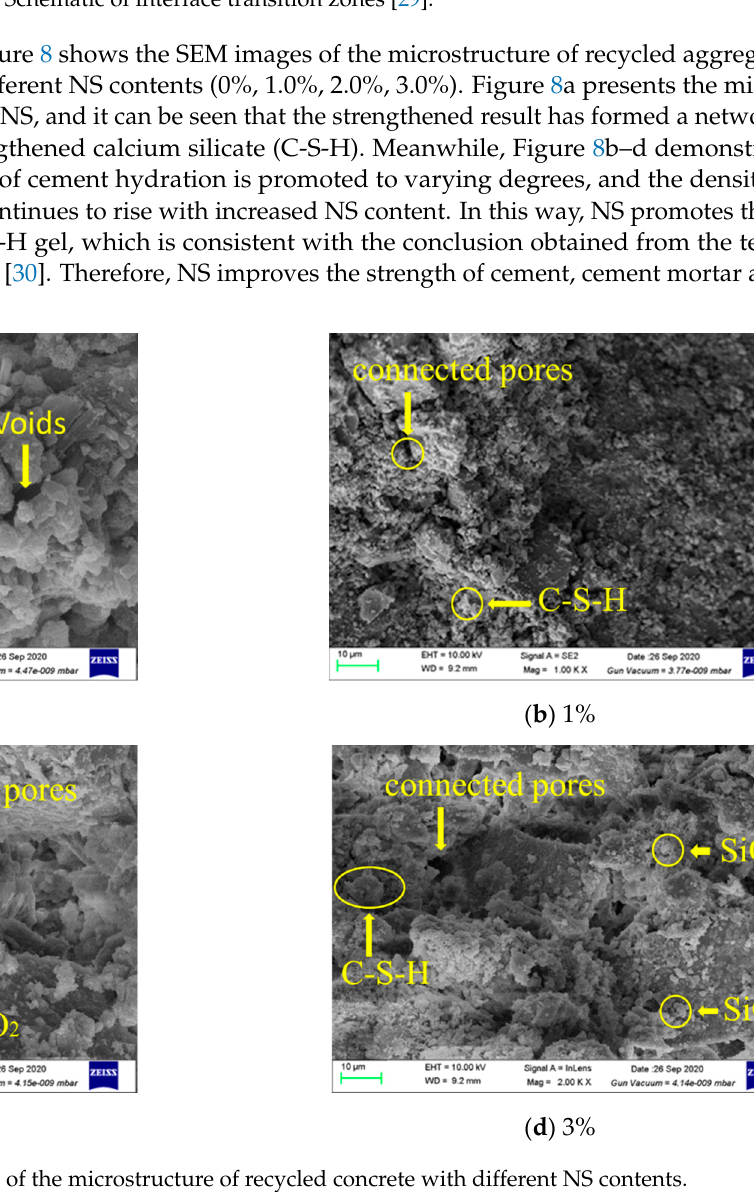
Figure 6. Relationship curve between confining pressure and peak stress.